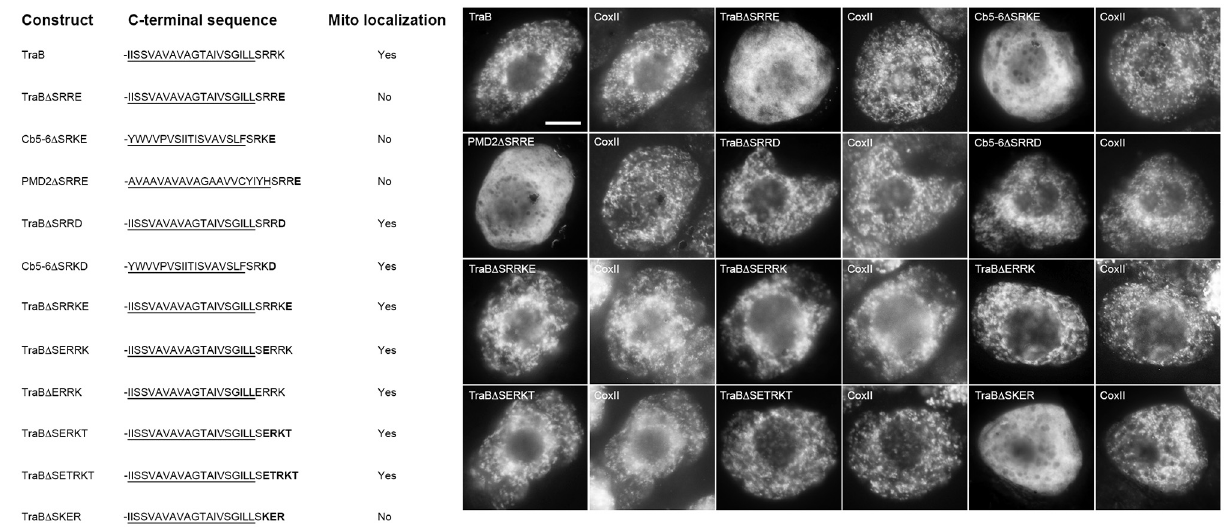
TraB, Cb5-6 and PMD2; modified amino acid residues in the protein’s CTS are bolded. Mitochondrial localization (indicated as “Yes” or “No”) was assessed based on colocalization (or lack thereof) of the expressed protein and endogenous mitochondrial CoxII. Shown on the right in both are representative immuno-epifluorescence micrographs illustrating the localization of the various constructs shown on the left . Each micrograph is labeled with the name of the expressed Myc-tagged wild-type and/or CTS mutant version of TraB, Cb5-6, or PMD2 or endogenous CoxII. Bar = 10 μ